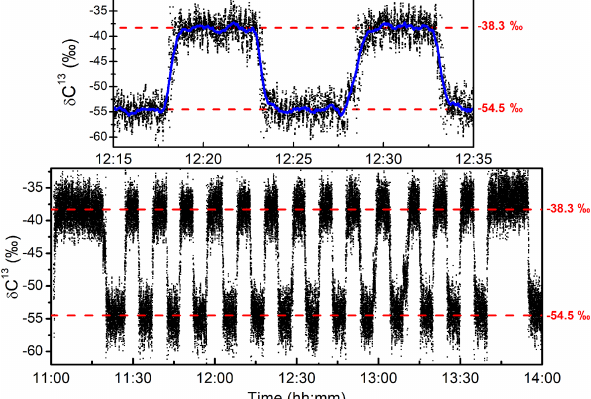
Figure 6. Long-term measurements obtained by repeatedly switch- ing between two methane samples in dry air having different sta- ble carbon isotopic composition. The two samples are diluted gas standards from Isometric Instrument with specified δ 13 C-CH 4 of − 54 . 5 ± 0 . 2‰ (79.4ppmv) and − 38 . 3 ± 0 . 2‰